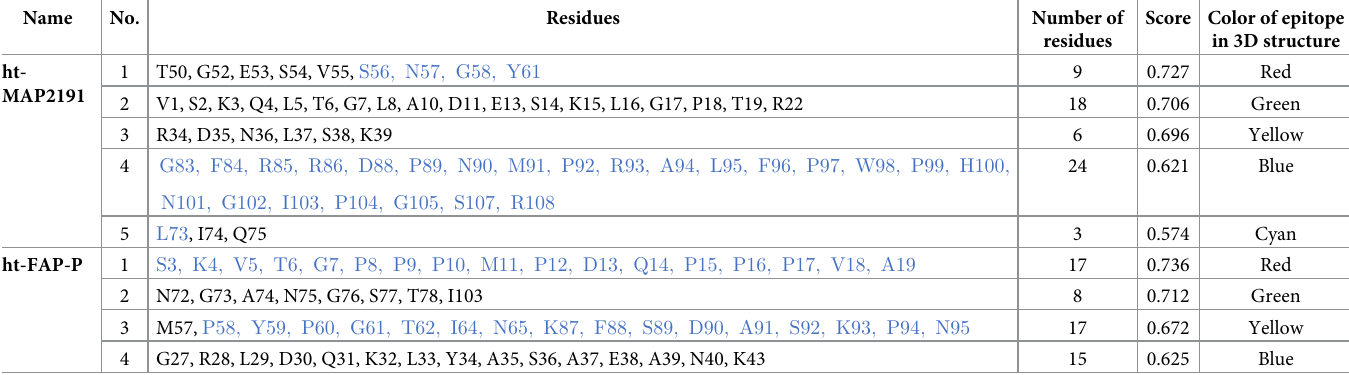
Table 6. The amino acid residue content of conformational B-Cell epitopes predicted by the ElliPro server. Common residues detected by both Ellipro and Discotope servers are marked in blue.